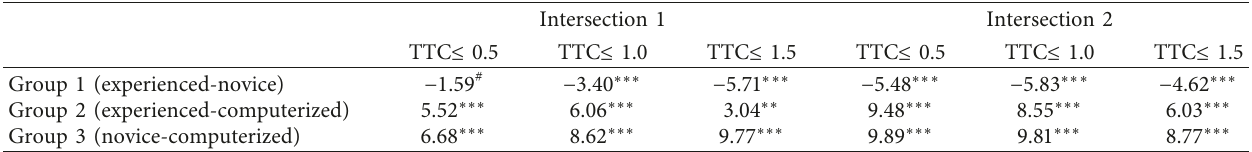
Table 3: Post-hoc test